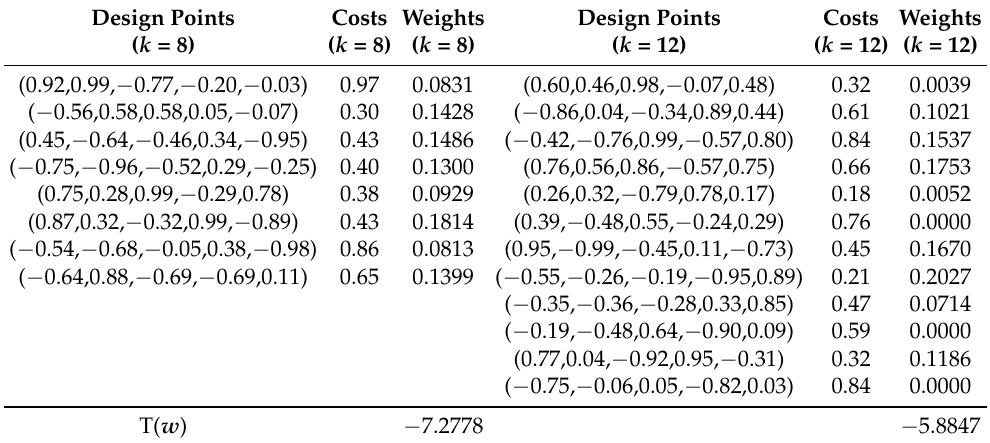
Table A1. Design points, costs, ED -optimal weights, and values of objective function (2) when p = 5. Design Points